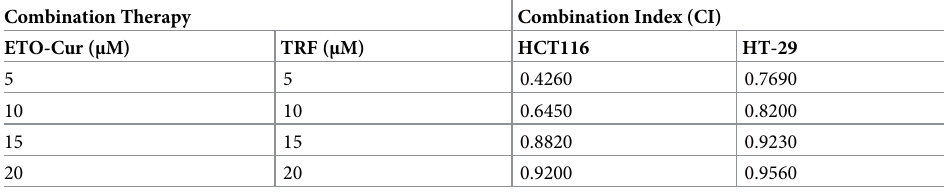
Table 1. Synergy analysis for ETO-Cur and TRF combination therapy in colon cancer